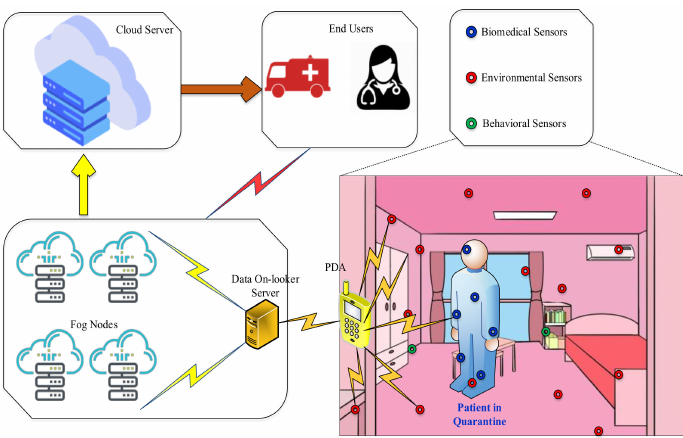
Figure 7. Covid-19 Remote Monitoring by